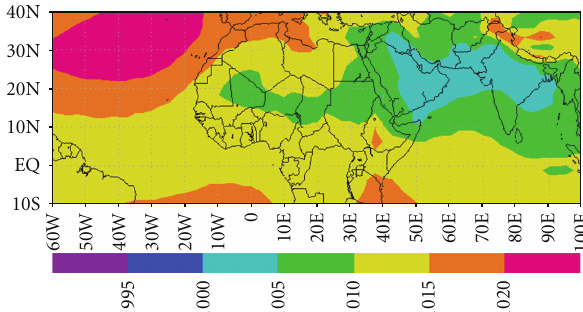
Figure 1: Average SLP for July, August, and September 1975–2005. Although the center of the SAL is situated over the region from the Arabian Peninsula eastward to northern India, its influence extends westward over the Sahara and the Sahel region.